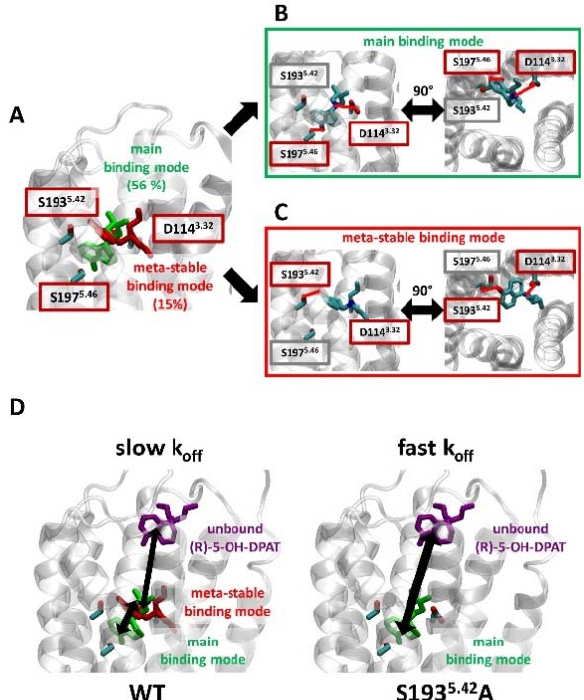
Figure 5. (R)-5-OH-DPAT forms a meta-stable binding mode with S193 5.42 . ( A ) Clustering simulations of (R)-5-OH-DPAT in complex with WT D 2 R, based on the RMSD of the ligand, reveal two binding modes. The main binding mode was maintained over 56% of the simulation frames (green) and a meta-stable binding mode was maintained over 15% of the simulation frames (red). ( B , C ). For each of the binding modes, the studied position S193 5.42 , as well as residues that form polar interactions with the ligand, are shown. These polar interactions are highlighted with red lines. ( D ) A model explaining the slow K off values observed for the unbinding of (R)-5-OH-DPAT from WT D 2 R. Before dissociating from the receptor (purple conformation), (R)-5-OH-DPAT bound in the main binding mode (green) assumes a meta-stable binding mode (red). When bound in this meta-stable binding mode, (R)-5-OH-DPAT can revert to the main binding mode or proceed to an unbound conformation. Hence, the dissociation of (R)-5-OH-DPAT is effectively slowed down by S193 5.42 . In comparison, at the S193 5.42 A mutant receptor, the absence of the meta-stable binding mode permits fast exchange between the bound and unbound conformations of